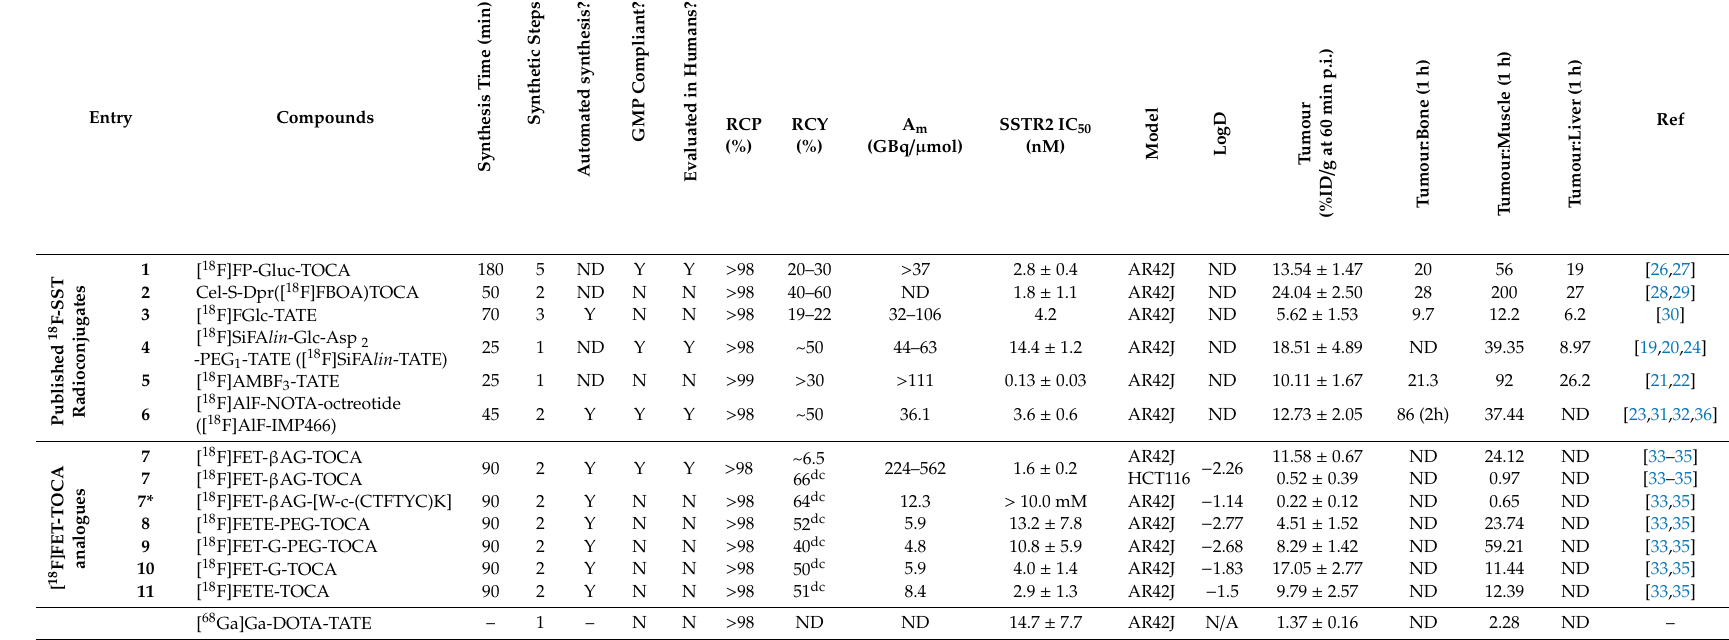
Table 1. Summary of 18 F-SSA radioconjugates discussed in this